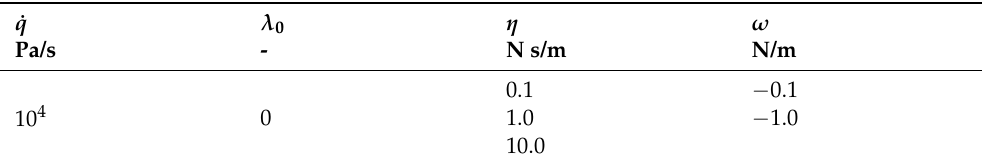
Table 3. Loading and damage material parameters used for the simulated macroscopic responses plotted in Figures